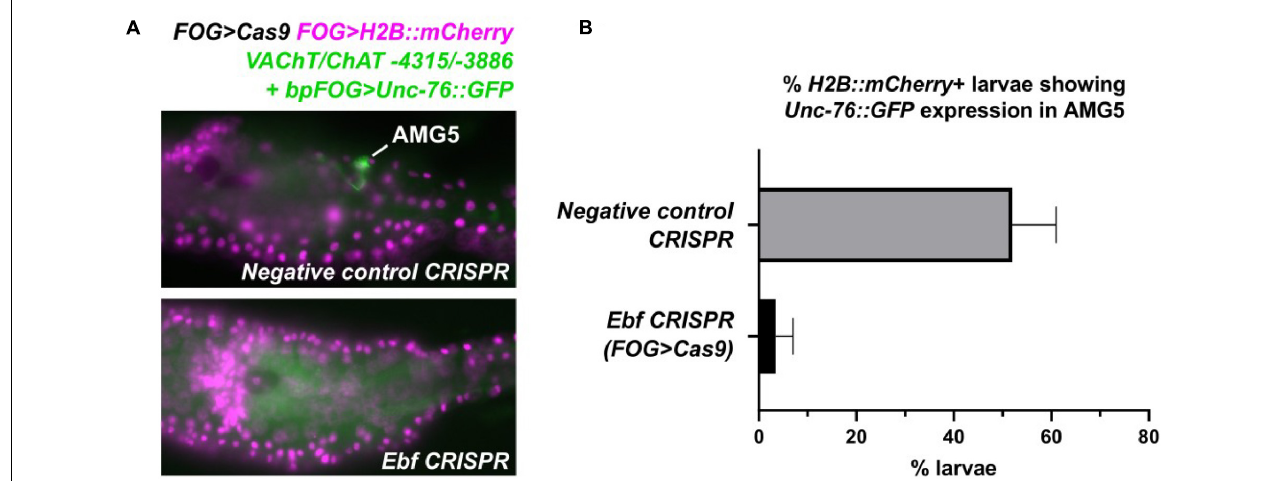
FIGURE 4 | Tissue-specific CRISPR/Cas9-mediated knockout of Ebf abolishes VAChT/ChAT expression in AMG5. (A) F0 larvae co-electroporated with FOG > Cas9, FOG > H2B:mCherry, and the AMG5-specific VAChT/ChAT reporter (- 4315/ - 3886 + bpFOG > Unc-76:GFP), and either a negative control guide RNA or an Ebf -targeting guide RNA (Gandhi et al., 2017) were scored for GFP signal in AMG5 at 17 h post-fertilization at 20 ◦ C. FOG > Cas9 restricts CRISPR activity to the animal pole-derived cells from which AMG5 is born. (B) Scoring results of negative control and Ebf CRISPR larvae, averaged over two replicates. Negative control: replicate 1 n = 54, replicate 2 n = 49. Ebf CRISPR: replicate 1 n = 58, replicate 2 n = 43. Error bars indicate range between replicates. These results indicate that knocking out Ebf in the animal pole mostly abolishes VAChT/ChAT reporter expression in